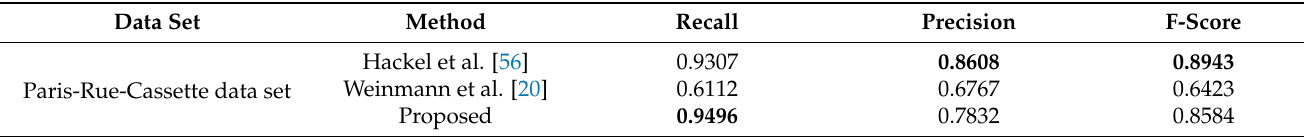
Table 6. Comparison results between the proposed and two existing methods on